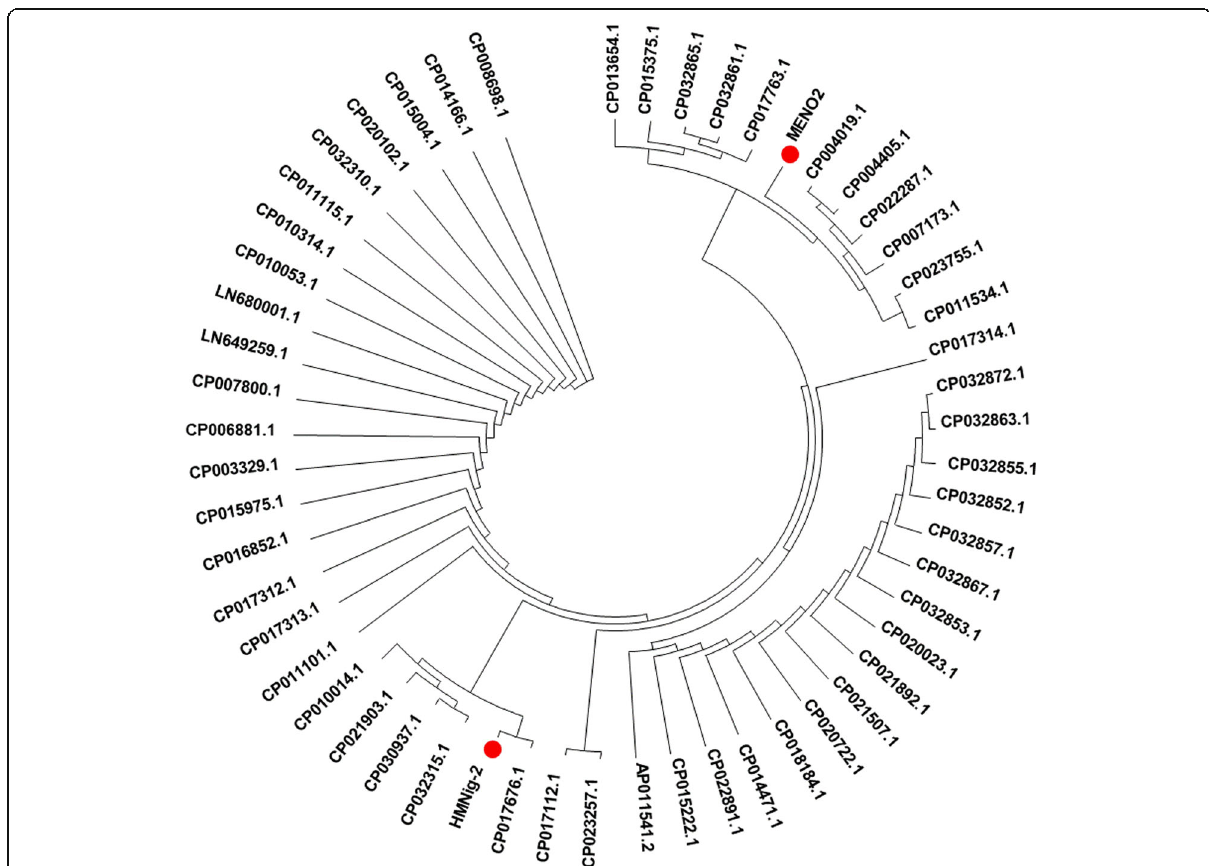
Fig. 3 Phylogenetic analysis based on the levansucrase encoded by sac B gene, their closest neighbors from other B. subtilis strains are shown. Accession numbers are given in parentheses. Phylogenetic analysis was performed using